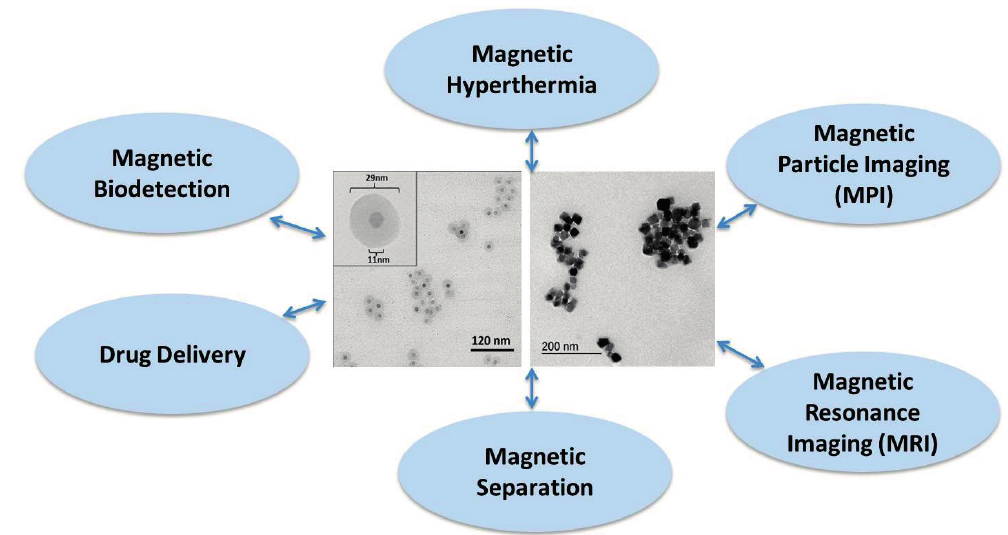
Figure 1. Biomedical applications of magnetic nanoparticles. Both single- and